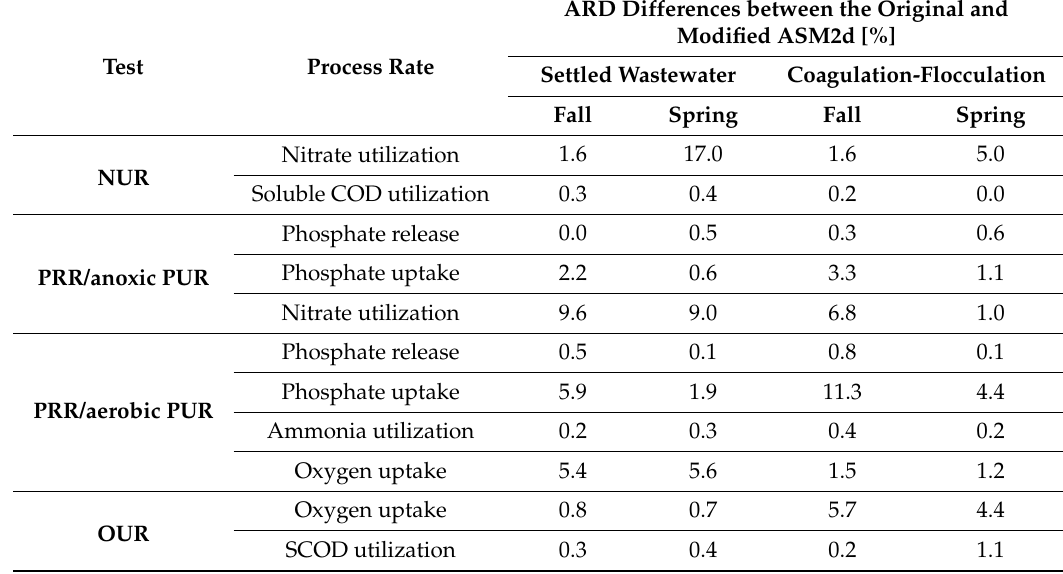
Table 3. Differences in the ARD obtained with the original and modified